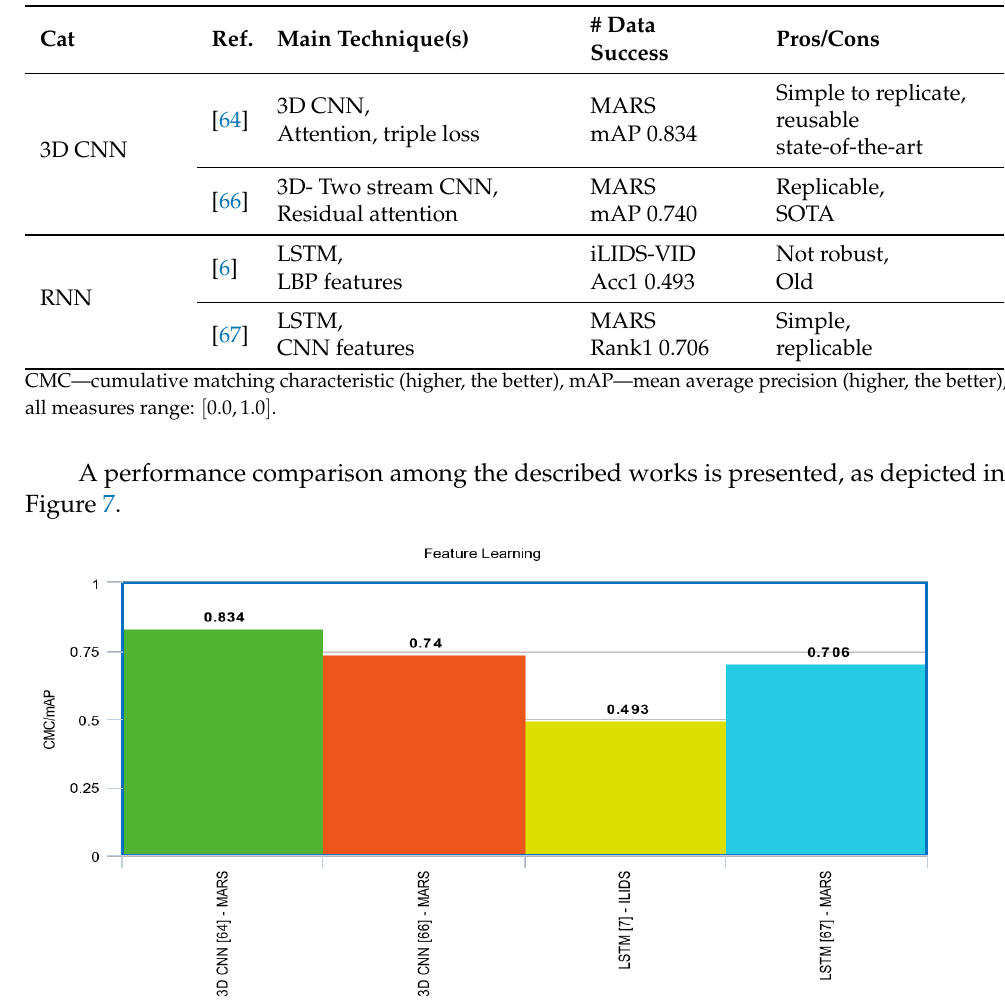
Table 4. Performance evaluation of the reviewed person ReID Sequence methods.